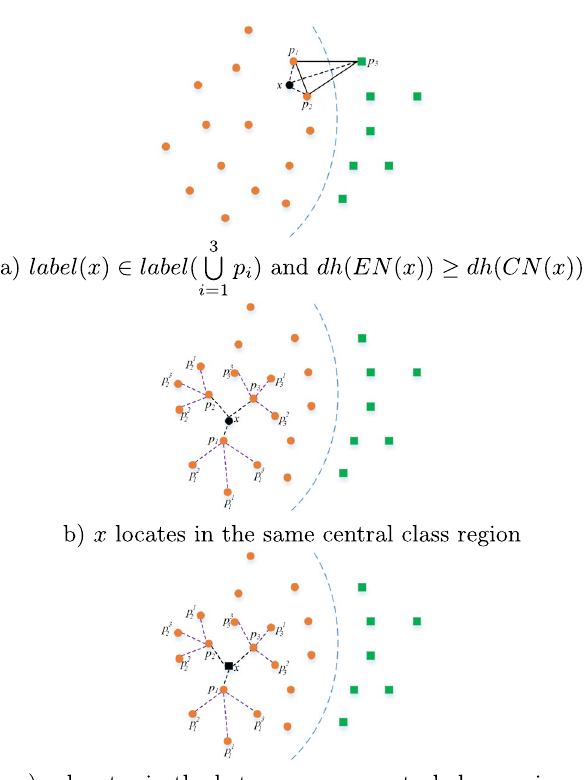
Figure 1. Prototype selecting schematic diagram.